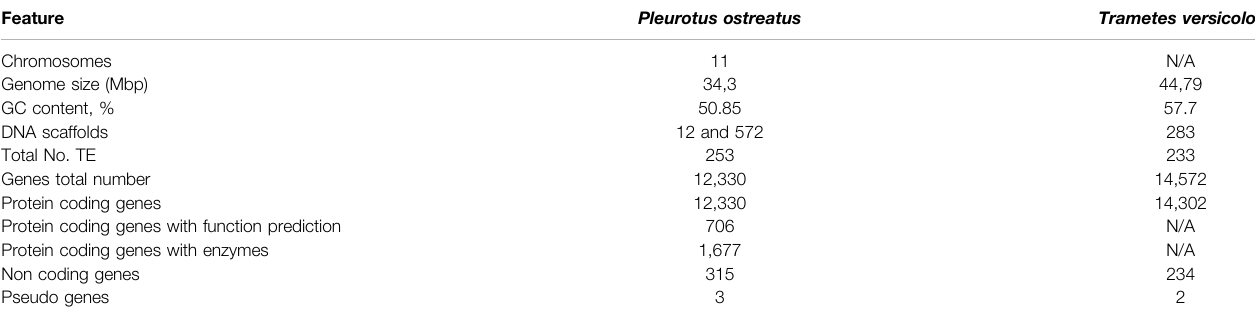
TABLE 1 | General features of the genome of P. ostreatus and T. versicolor